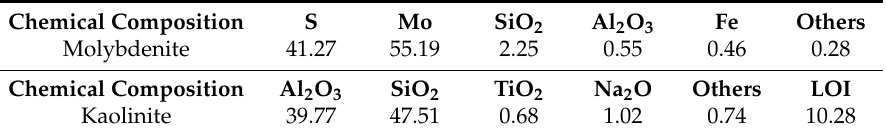
Figure 1. X-ray diffraction spectrum of pure molybdenite. Table 1. Chemical contents of the pure molybdenite and kaolinite samples.